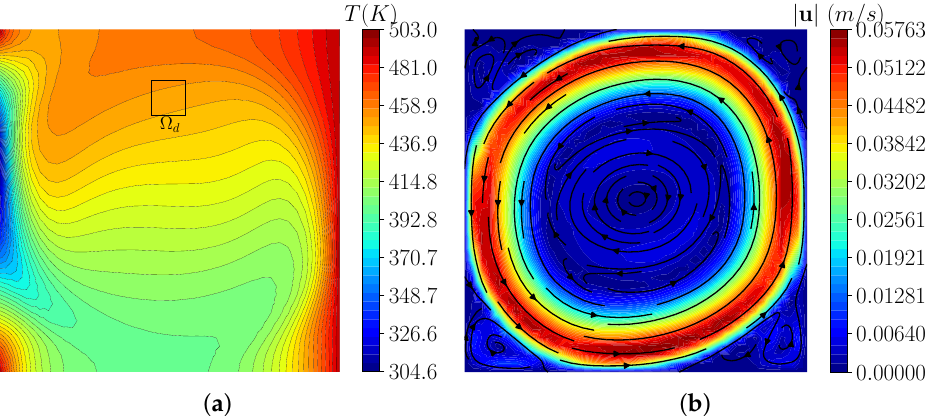
Figure 3. Temperature matching case with Dirichlet boundary control: optimal solution for λ = 10 − 7 . Contours of the temperature field T ( a ); contours and streamlines of the velocity field u ( b ). The u velocity magnitude is indicated by , and Ω d is the region where the objective is set. | |